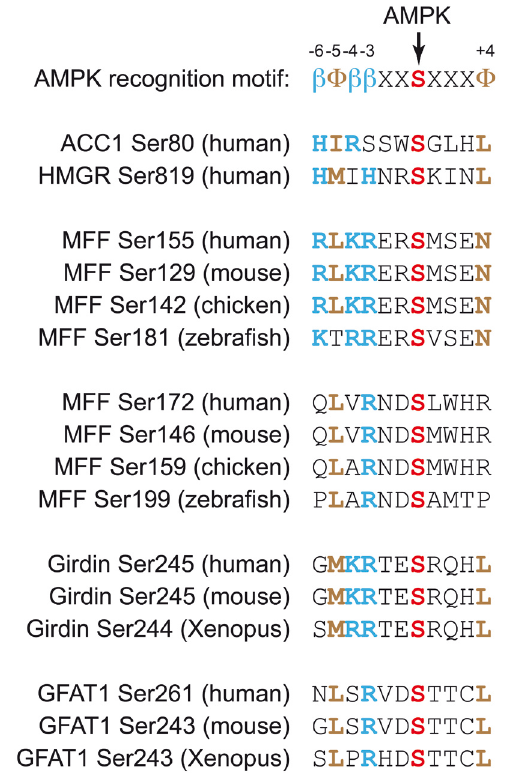
Figure 3. Alignment of consensus recognition motif for AMPK, classic sites phosphorylated by AMPK on acetyl-CoA carboxylase-1 (ACC1) and HMG-CoA reductase (HMGR), and novel sites recently identified on MFF, Girdin, and GFAT1. Basic residues at the -6, -4, and -3 positions are indicated in blue by the symbol “ β ” in the recognition motif and otherwise by the single- letter code in bold type. Hydrophobic residues at the -5 and +4 positions are indicated in brown by the symbol “ Φ ” in the recognition motif and otherwise by the single-letter code in bold type. Serine residues directly phosphorylated by AMPK are indicated in red bold type. In most cases, the sites were identified by using the human or mouse sequence, but the alignments show conservation of the sequences in other vertebrates. AMPK, AMP-activated protein kinase; GFAT1, glutamine:fructose-6-phosphate amidotransferase- 1; MFF, mitochondrial fission